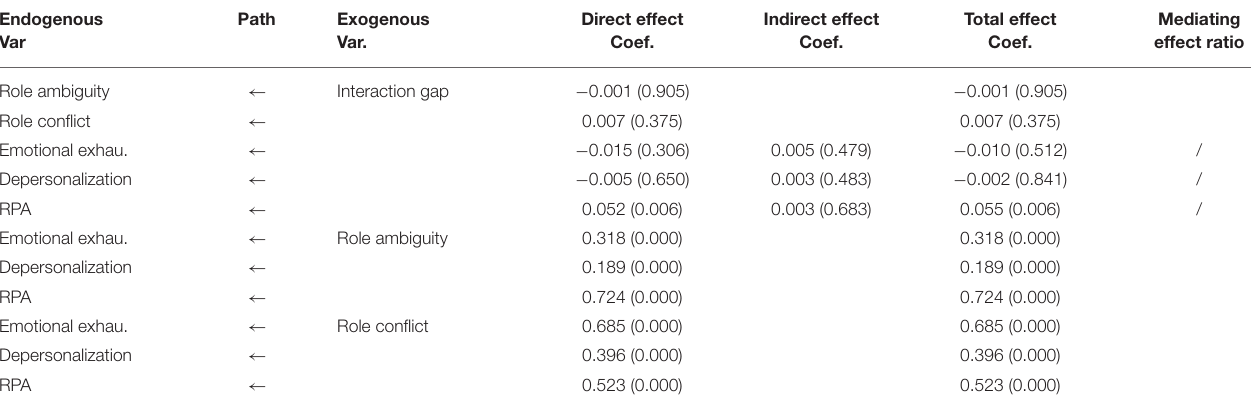
Path Exogenous Var.